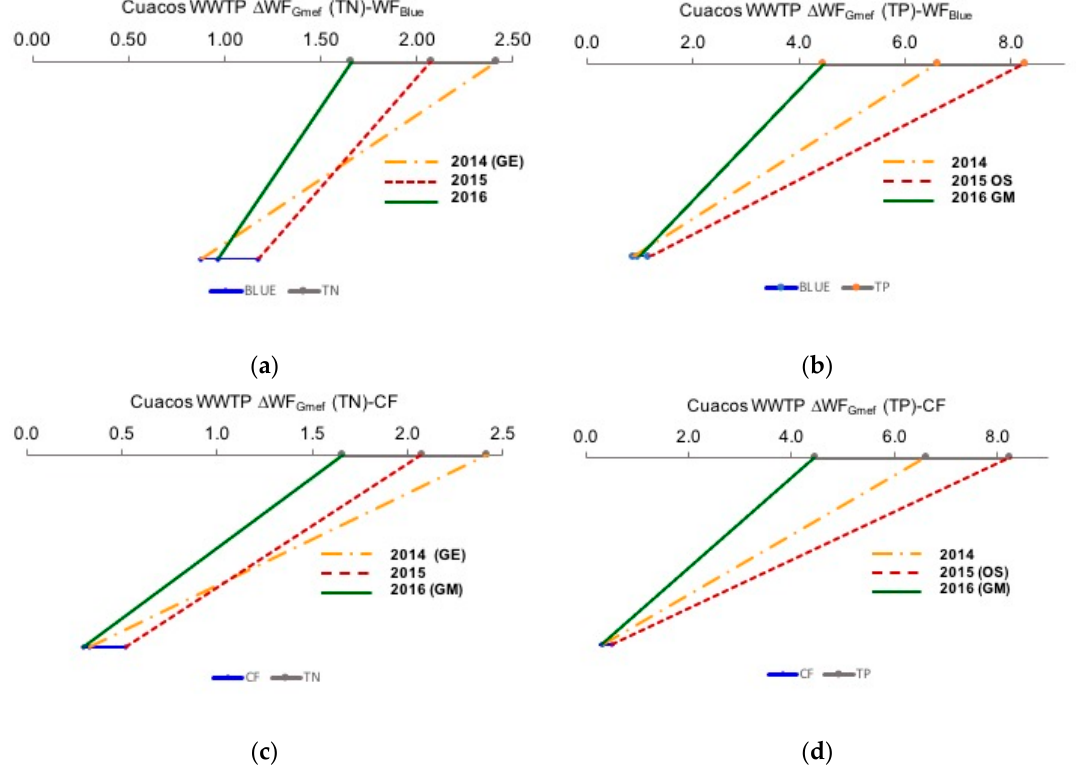
Figure 6. Relationships among average values per cubic metre of treated water for WF Blue or CF and ∆ WF G,mef in 2014, 2015 and 2016 at Cuacos WWTP. GE, good environmental performance limit; GM, good manager performance limit; OS, operational scenario to reduce consumption; PE, poor